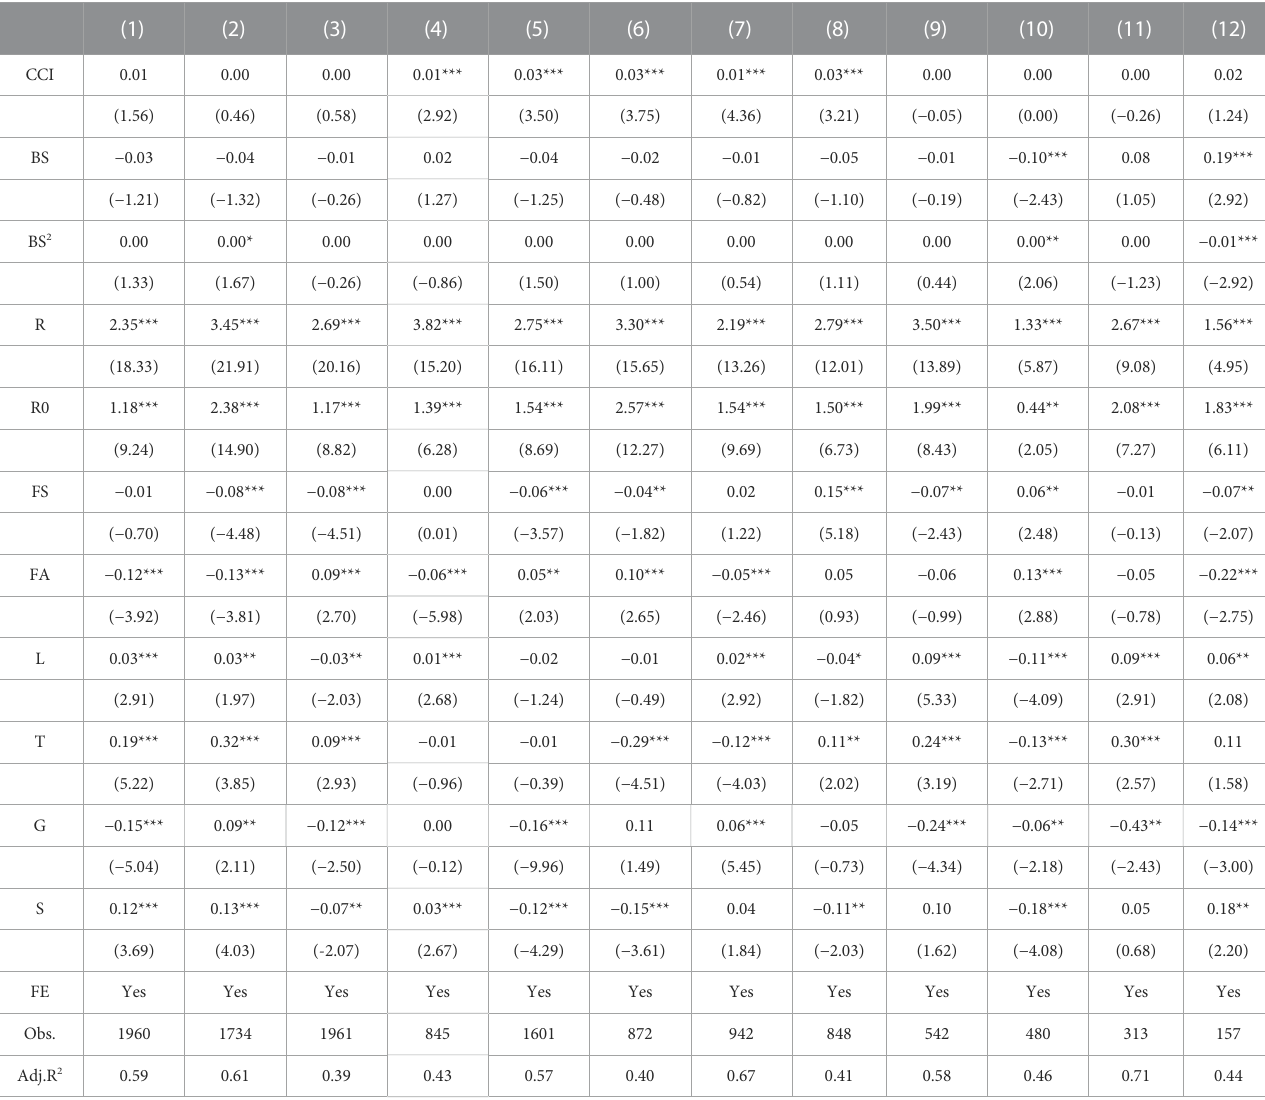
TABLE9EffectofnetworkpropertiesonTobin ’ sqaccordingtoeachindustry.CCIisthecompositecentralityindex,BSisboardsize,BS 2 isthesquaretermofboardsize, R is ROA, R0 is lagged ROA, FA is fi rm age, FS is fi rm size, L is leverage, T is tangibility, G is growth, and S is sale, including year fi xed effects. Columns (1) – (12) present coef fi cient estimates for various subsamples including industry fi xed effects. For various subsamples, the table represents the estimation results for an ordinary least square of board network characteristics and other control variables on Tobin ’ s q. (1) Manuf, (2) Shops, (3) BusEq, (4) Money, (5) Other, (6) NoDur, (7) Utils, (8) Hlth, (9) Chems,(10)Energy,(11)Durbl,and(12)Telcm.T-values areinparentheses.*,**,and*** indicatesigni fi canceatthe 10%,5%,and1%levels,respectively. Allvariables are winsorized at 1% and